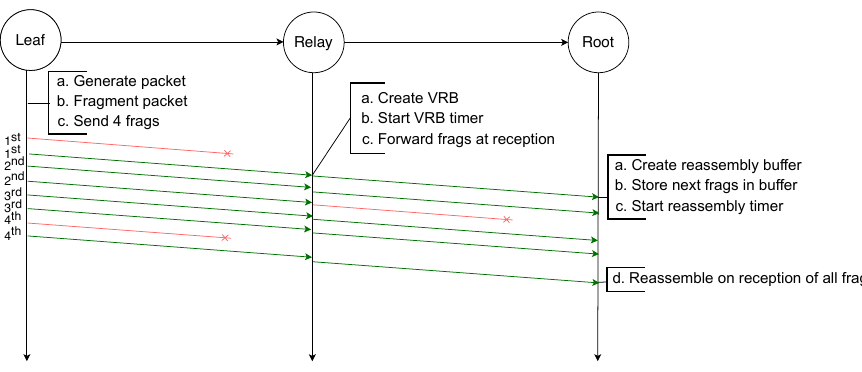
Figure 10. Successful transmission of a packet with